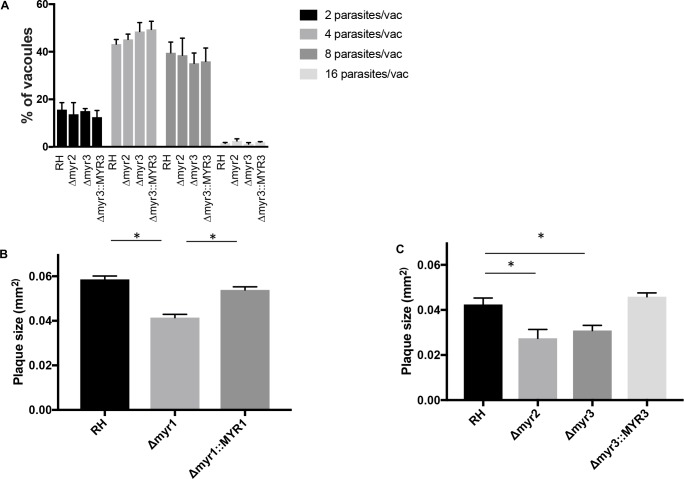
MYR1, MYR2, and MYR3 are necessary for fully efficient growth in vitro.(A) HFFs were infected with tachyzoites of the indicated strains for 20 hours, fixed, and then stained with antibody to SAG1 to assess the number of parasites per vacuole. The results indicate the percentage of vacuoles containing 2, 4, 8, or 16 parasites. The averages are based on 3 independent replicates, and error bars reflect SEM. (B, C) HFFs were infected with tachyzoites of the indicated strains for 6 days, fixed with methanol, and then stained with crystal violet. Plaque size was measured using ImageJ. The averages are based on results from at least 3 independent biological replicates, each with 2–3 technical replicates, and error bars indicate SEM. *p < 0.005 using one-way ANOVA and Tukey’s multiple comparison’s test.